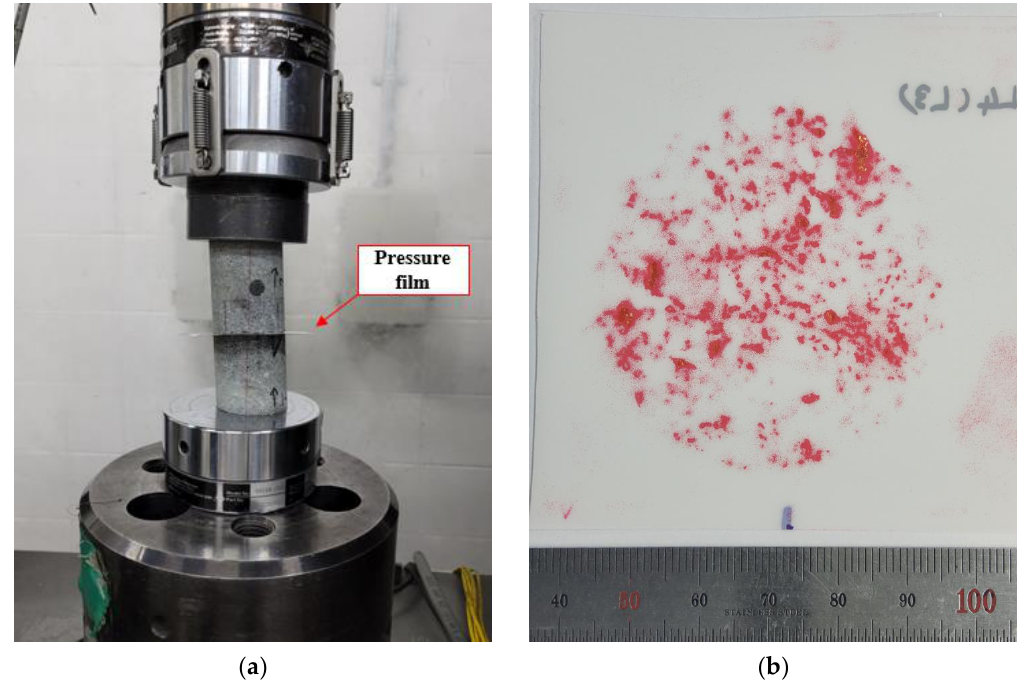
Figure 2. Example of pressure film image data acquisition: ( a ) pressure film compression test; ( b ) pressure film image data.